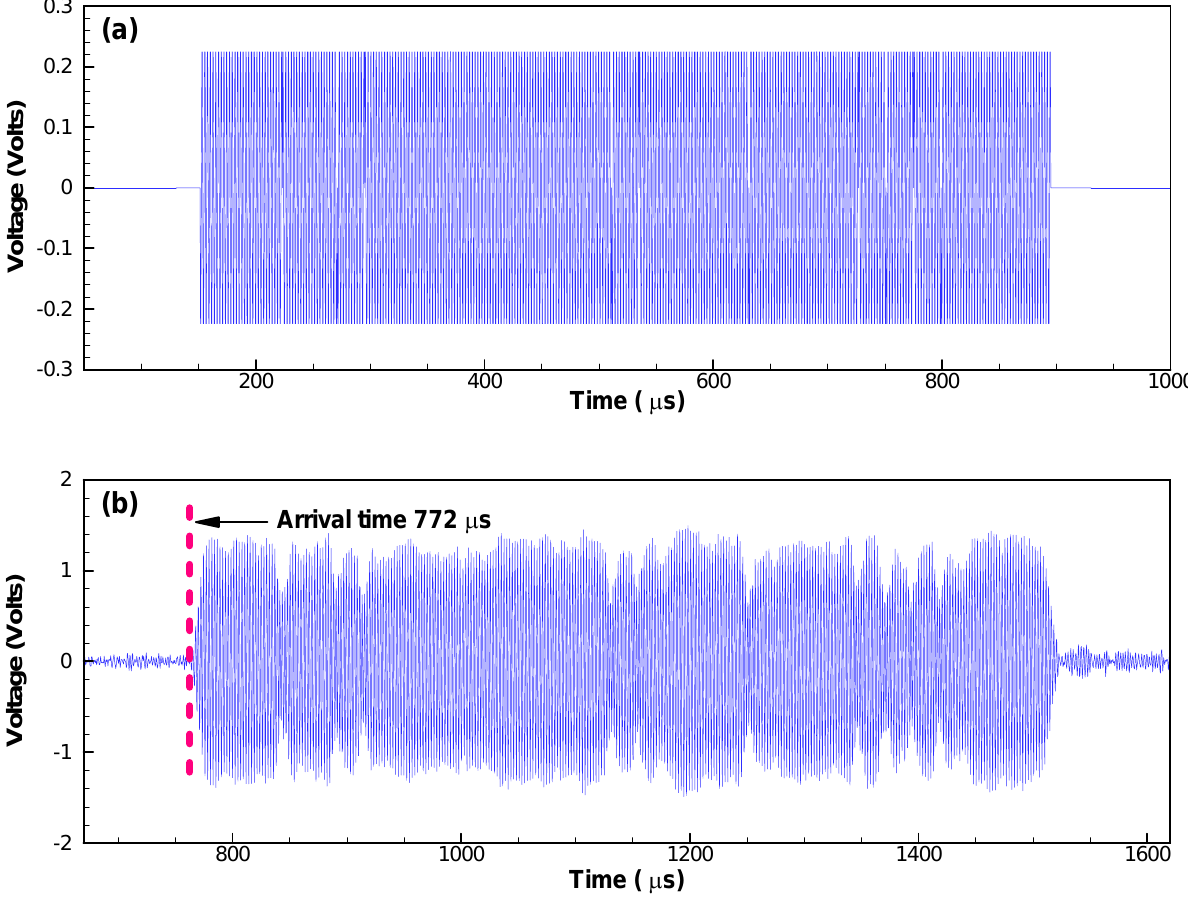
Figure 4. Comparison of original simulated waveform and acquired waveform. Note that there is a slight delay due to the travel time of the signal and latency of hardware triggering. However, this delay has no impact on the measurements because only the message portion of the waveform is used for